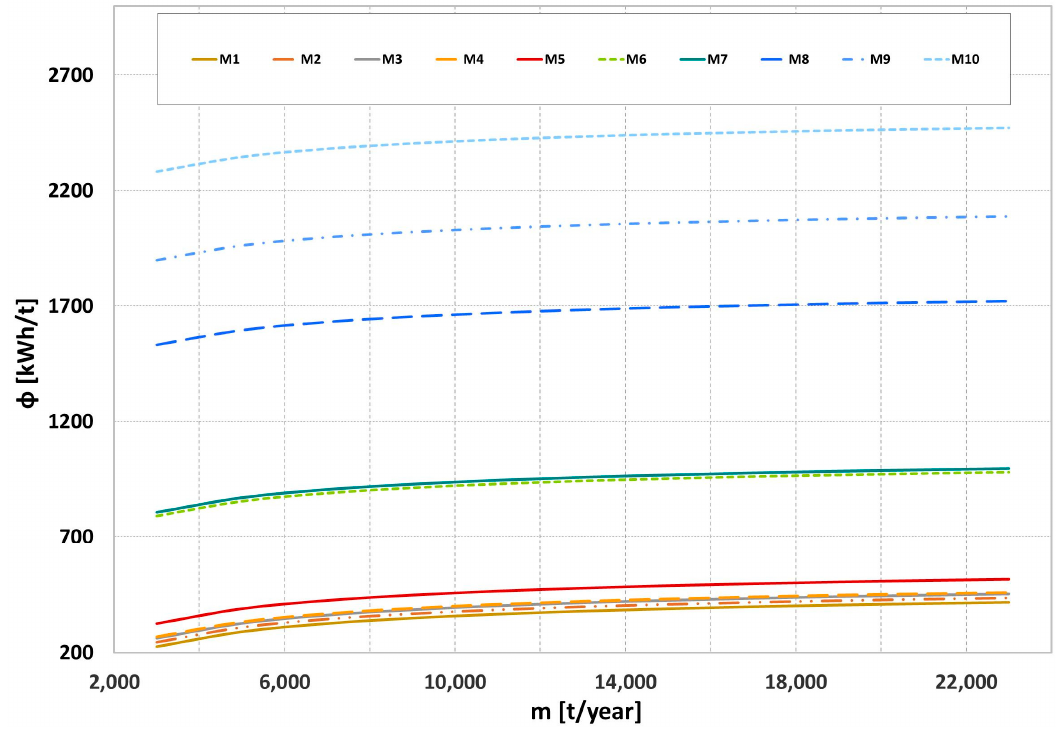
Figure 5. Net energy production of biogas production plant with changes in yearly flow rate and substrate typology.